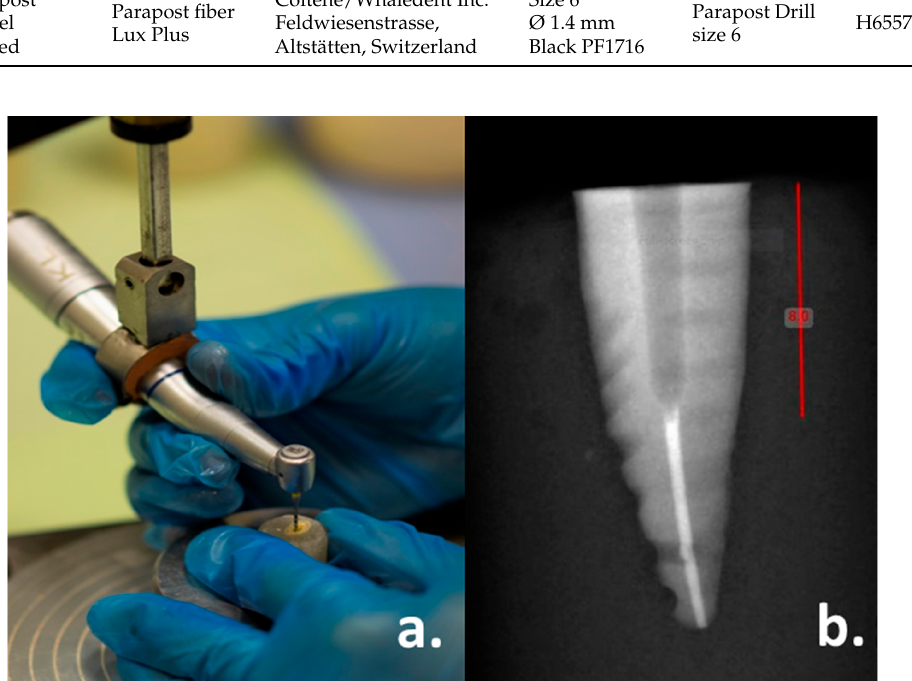
Figure 2. ( a ): Customized surveyor used during post space preparations; ( b ): Radiograph after post space preparation.